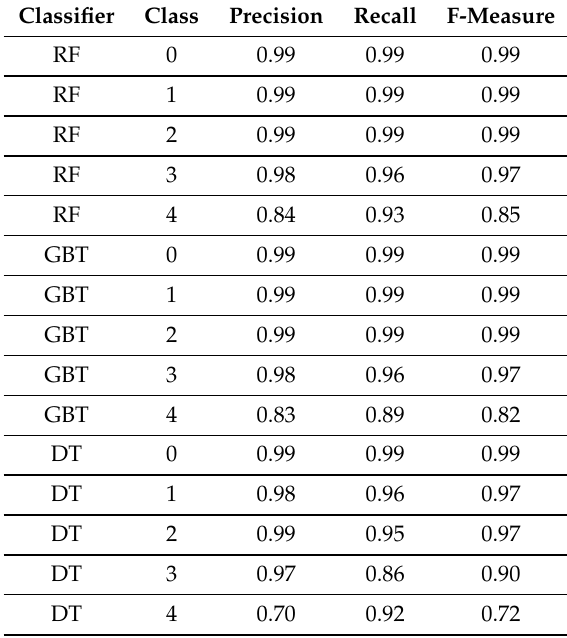
Table 2. Classification results, correlation threshold 0.5.